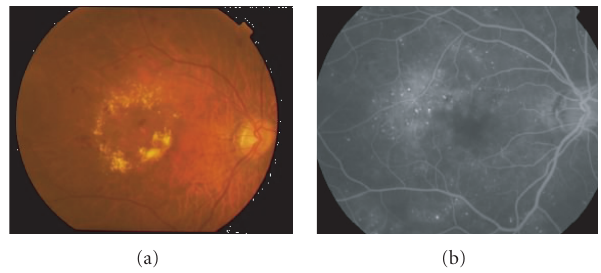
Figure 1: Macular edema in diabetic retinopathy. (a) Macular edema in diabetic retinopathy. (b) Increased vascular permeability is observed by fluorescin angiography. Note the leakage of the fluo- rescent dye showing the blood retinal barrier breakdown. Although the retinopathy is mild, this patient has a visual acuity of 20/200 due to severe macular edema.